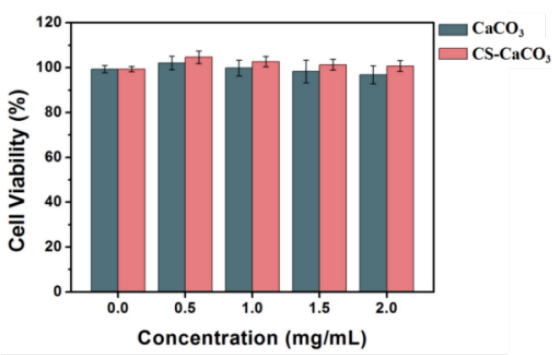
Figure 5. Viability of fibroblast cells after 12 h exposure to various materials and negative control (TCPS). Data were obtained using CCK-8 assay.